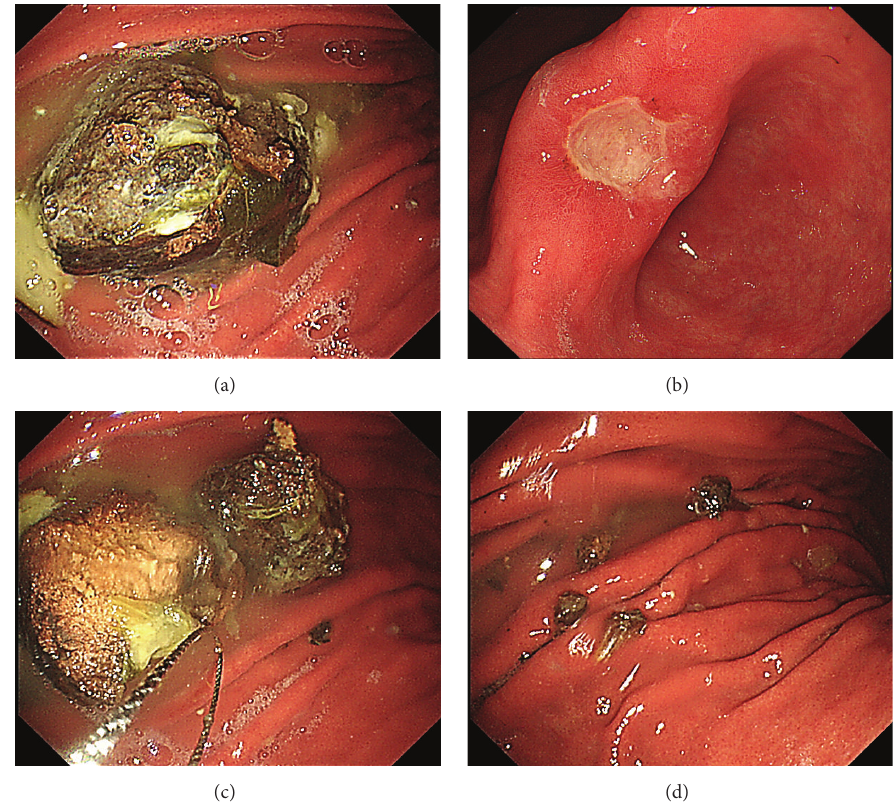
Figure 3: (a, b) Approximately 4 cm of the bezoar with a gastric ulcer (A2 stage) in the lesser curvature. (c) The polypectomy snare and gripping forceps were utilized for fractioning. (d) Successful removal of the